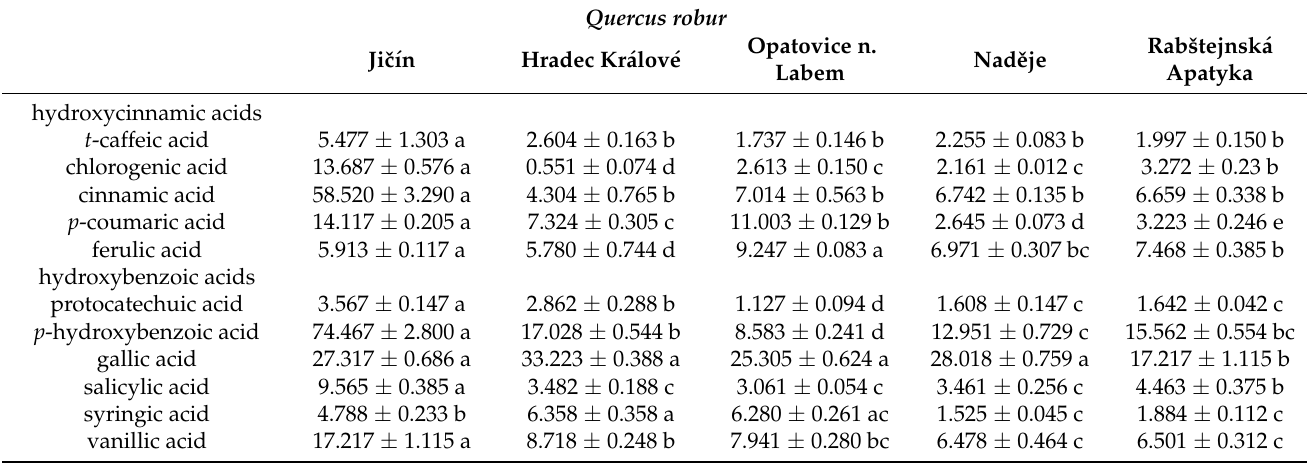
Table 3. The content of phenolic acids ( µ g g − 1 FW) in bud extracts of Quercus robur . Values are expressed as mean ± SDs ( n = 5). Different letters in lines show significant differences ( p < 0.05) according to Tukey’s test.